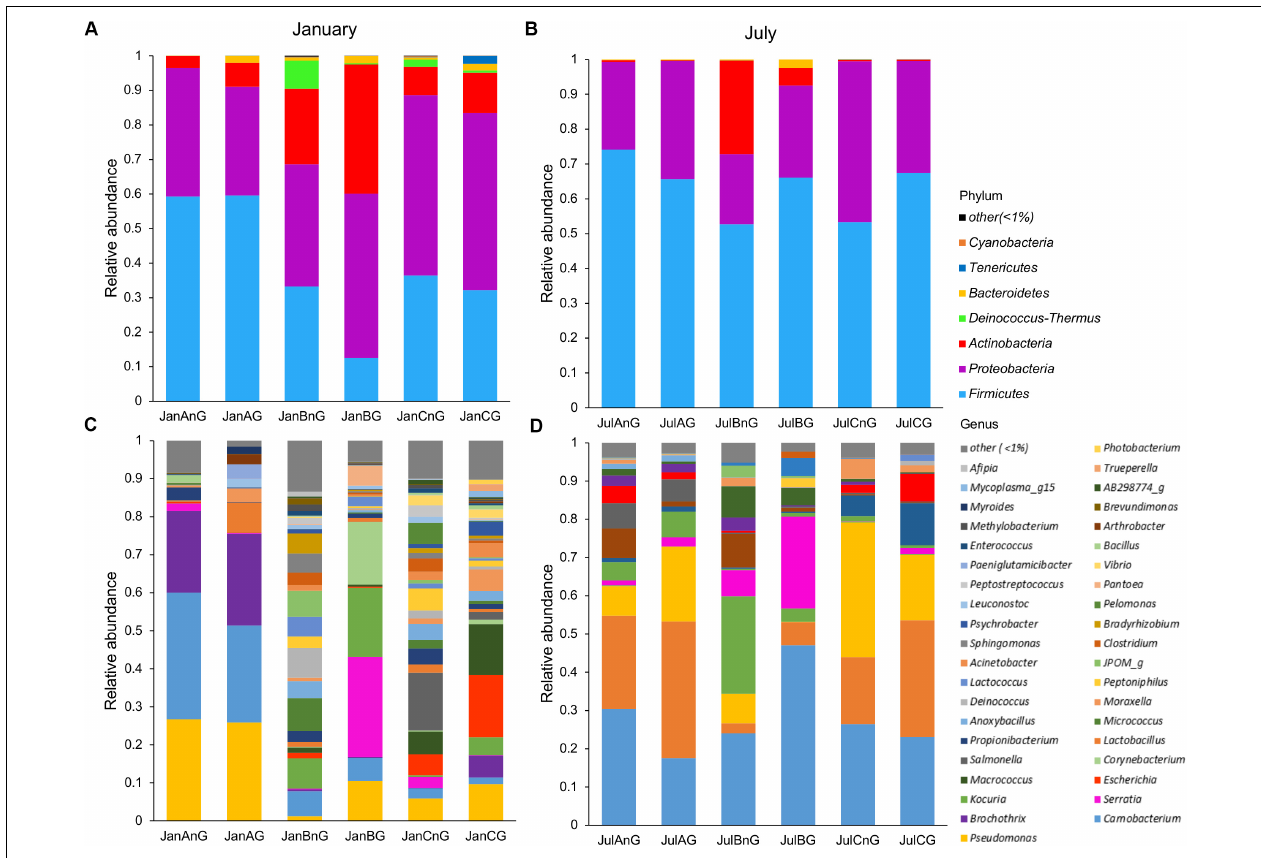
FIGURE 2 | The composition of microbiota was compared among samples at the phylum and genus levels. Comparison of phylum composition in beef meat collected in (A) January and (B) July. Comparison of genus composition collected in (C) January and (D) July. Taxa with relative abundance < 1% in each sample were combined with the “other”